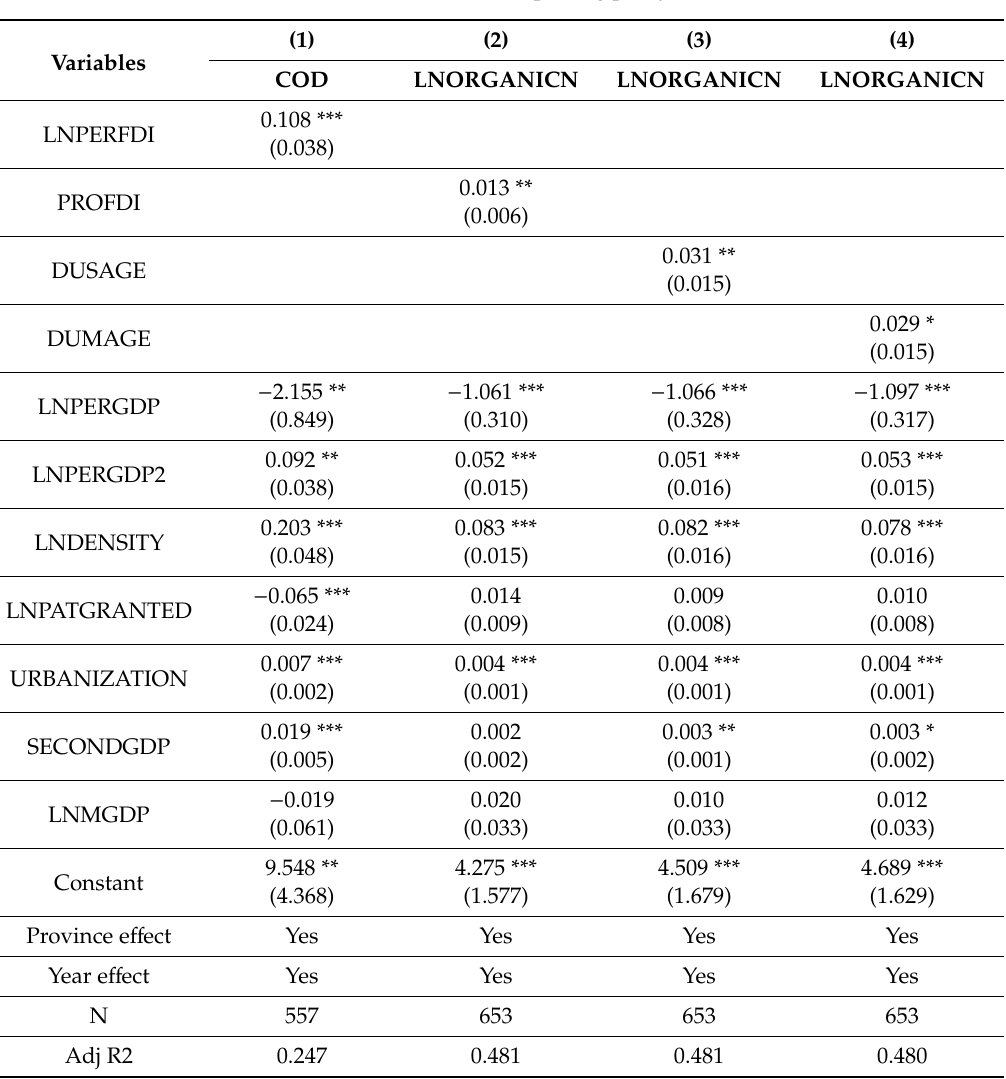
Table 3. Estimation results of replacing proxy